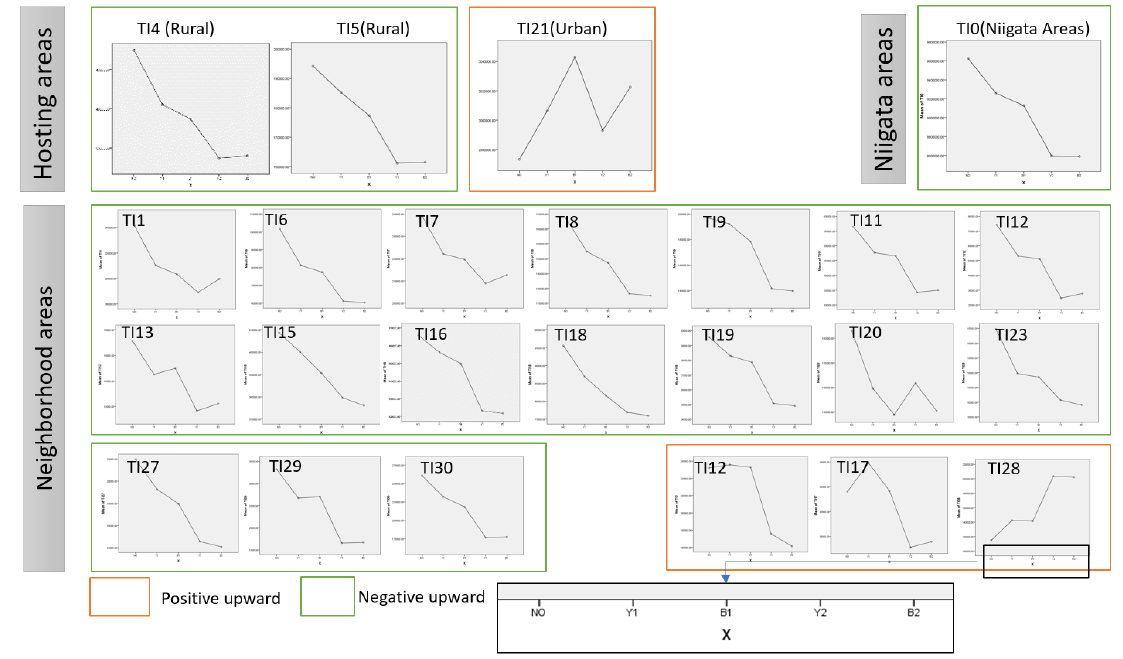
Figure 7. Mean plots (TI, TIGR): other areas in Niigata.